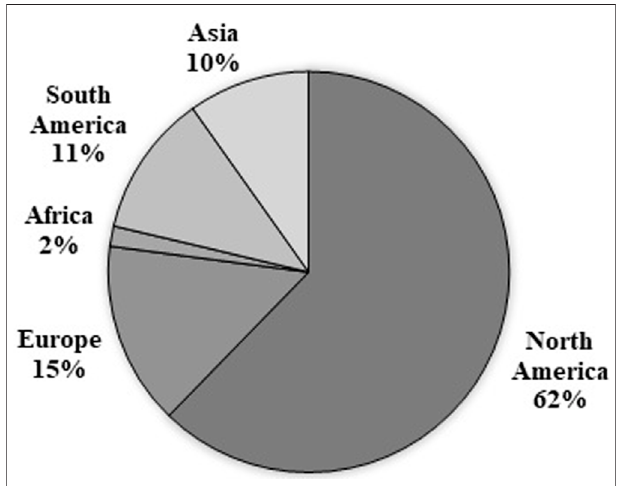
FIGURE 8 | Geographical region of the case study (continent).